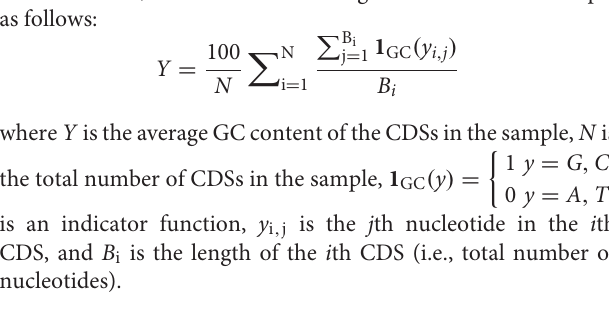
Frontiers in Microbiology |